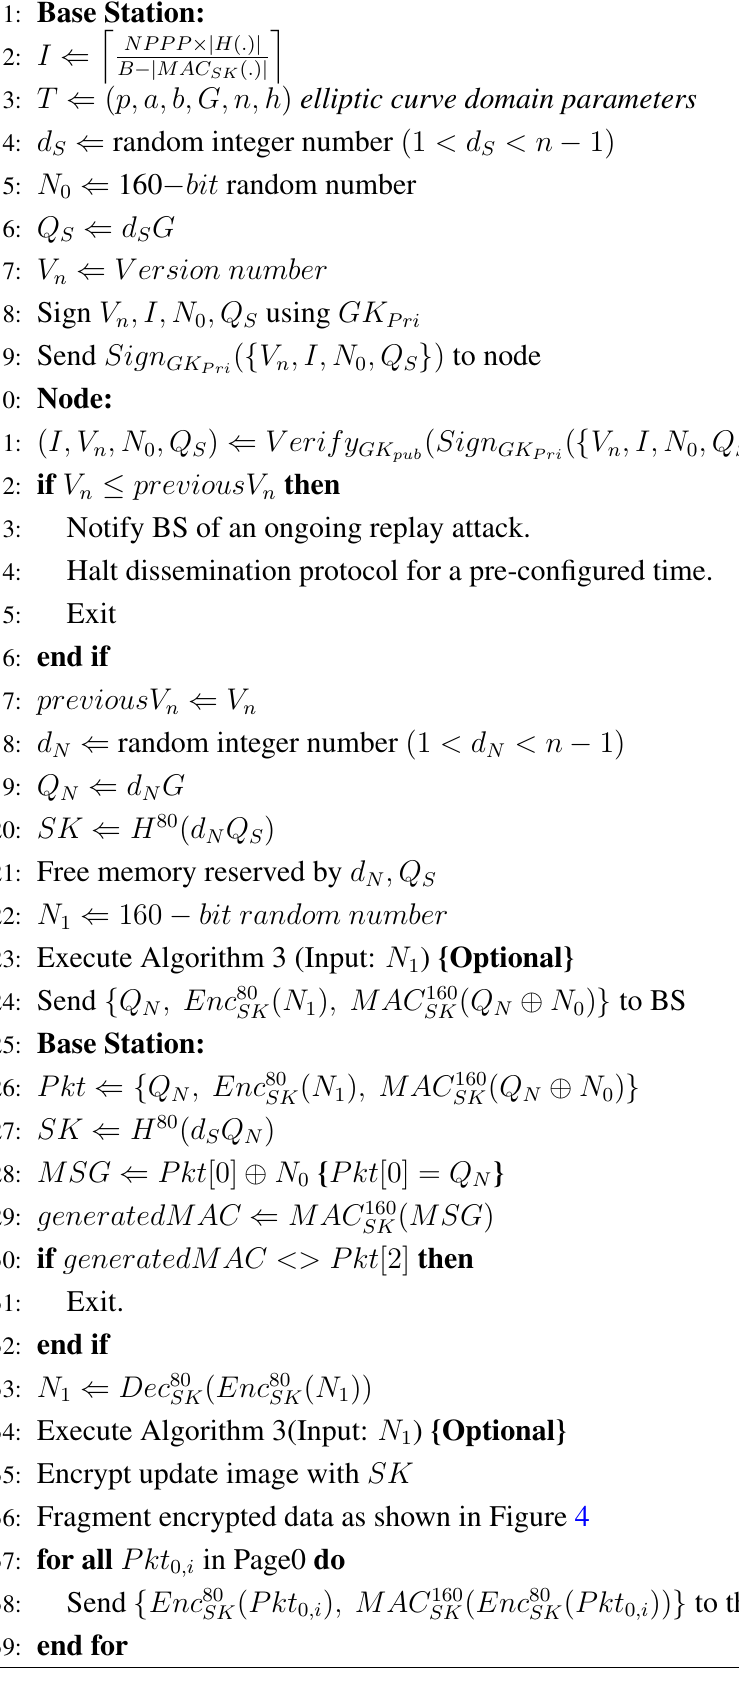
Algorithm 2 Dissemination of the code update, including the Data Verification (DV) and Hash Verification (HV)